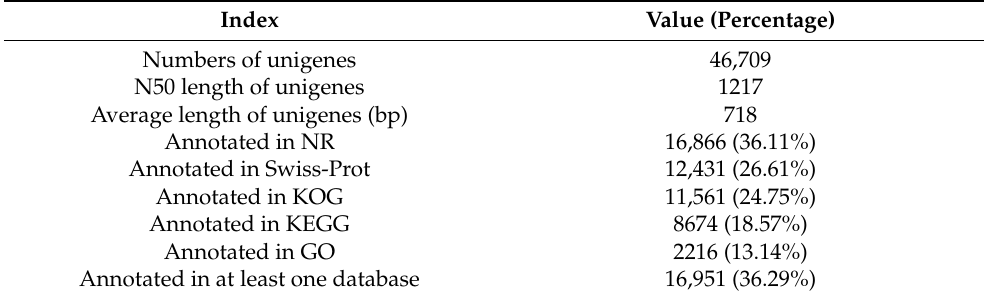
Table 1. Summary statistics of transcriptome data from Palaemon carinicauda